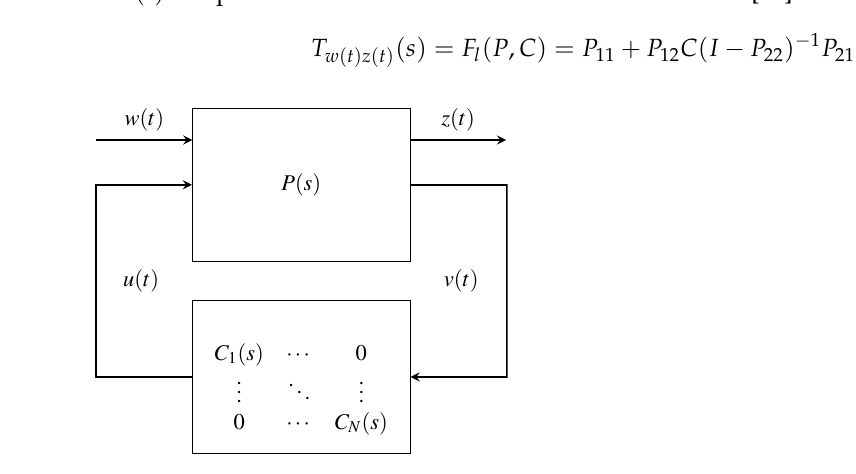
Figure 6. Diagram of a standard representation for a structured H ∞